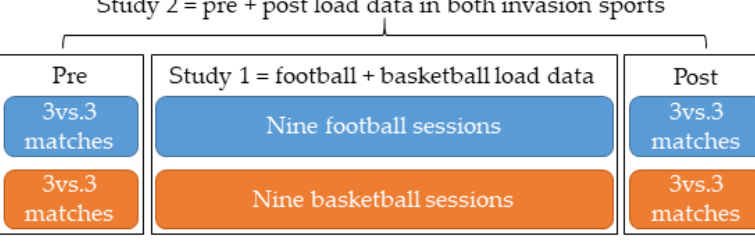
Figure 2. Procedure for both studies.